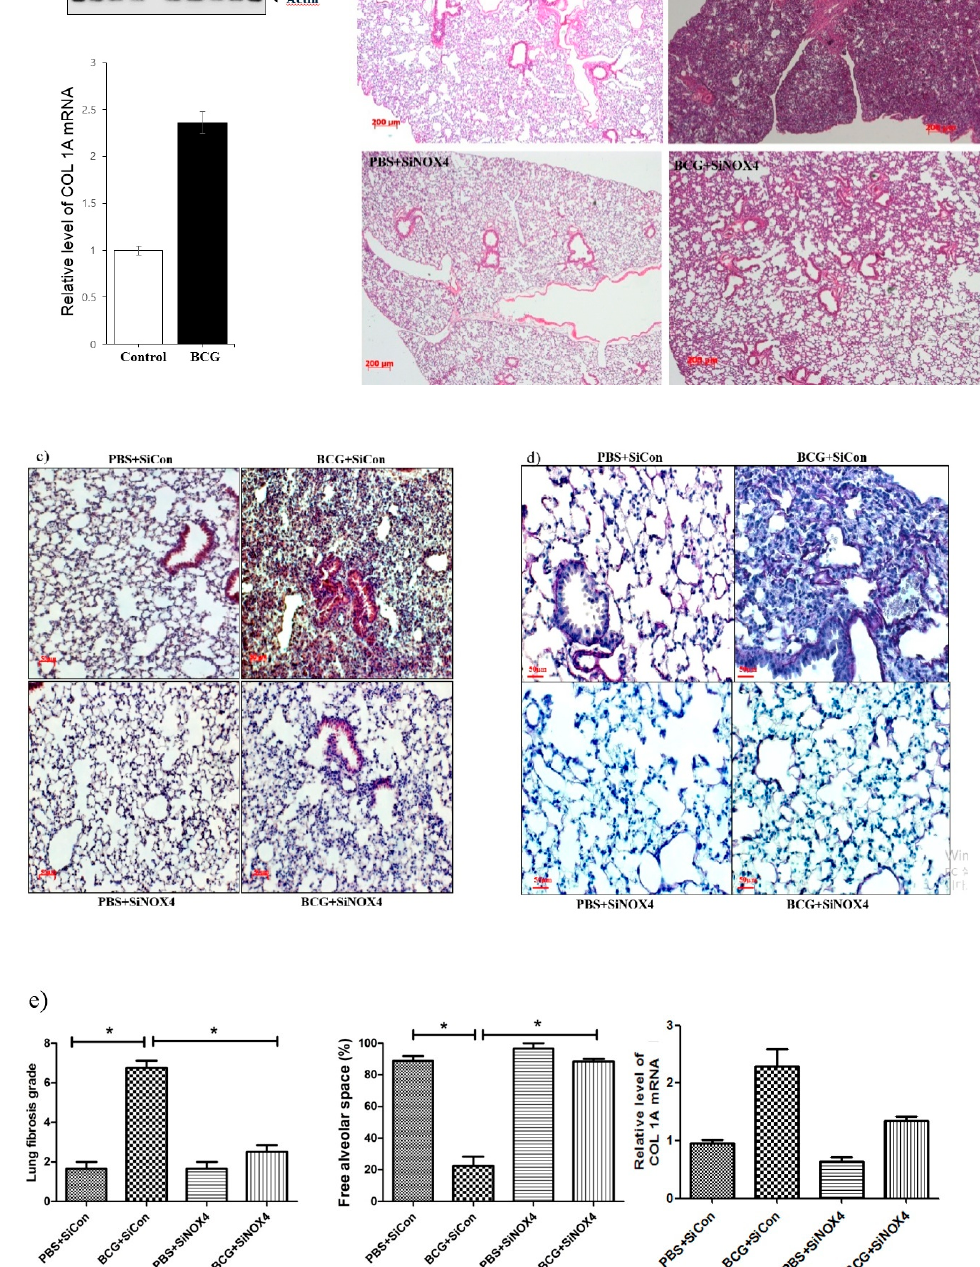
Figure 6. NOX4 levels increase in BCG-induced pleurisy lung fibrosis. SiNOX4 post-treatment attenuates the hyperplasia of the visceral pleura, granuloma, and bronchiolitis induced by BCG in the mouse model. ( a ) Western blotting analyses of NOX4 and Collagen-1A mRNA concentration by RT-PCR. ( b ) Microscopic examination of lungs at days15 in four groups (PBS + SiCon group, BCG + SiCongroup, PBS + SiNOX4 group, and BCG + SiNOX4 group). Seven mice per group were analyzed. Scale bar: 200 µ m. ( c ) Immunostaining of NOX4 in mouse lungs. Scale bar: 50 µ m. ( d ) Immunostaining of Elastica van Gieson in mouse lungs. (Collagen: red color). Scale bar: 50 µ m. ( e ) Quantification of lung fibrosis and free alveolar space. * p < 0.05. BCG, Mycobacterium bovis bacillus Calmette-Gu é rin; PBS, phosphate buffered saline; COL1A, collagen